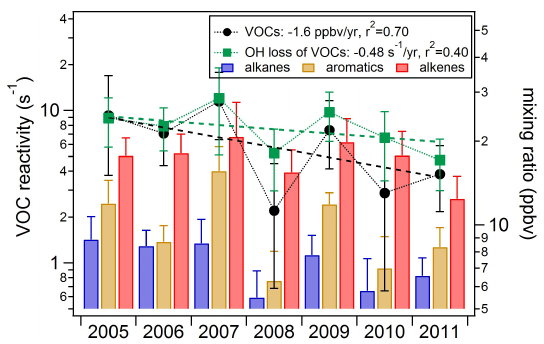
Figure 8. Variations in the daytime averages of n -pentane (red dots) and i -pentane (blue squares) mixing ratios in Beijing, August be- tween 2005 and 2011.